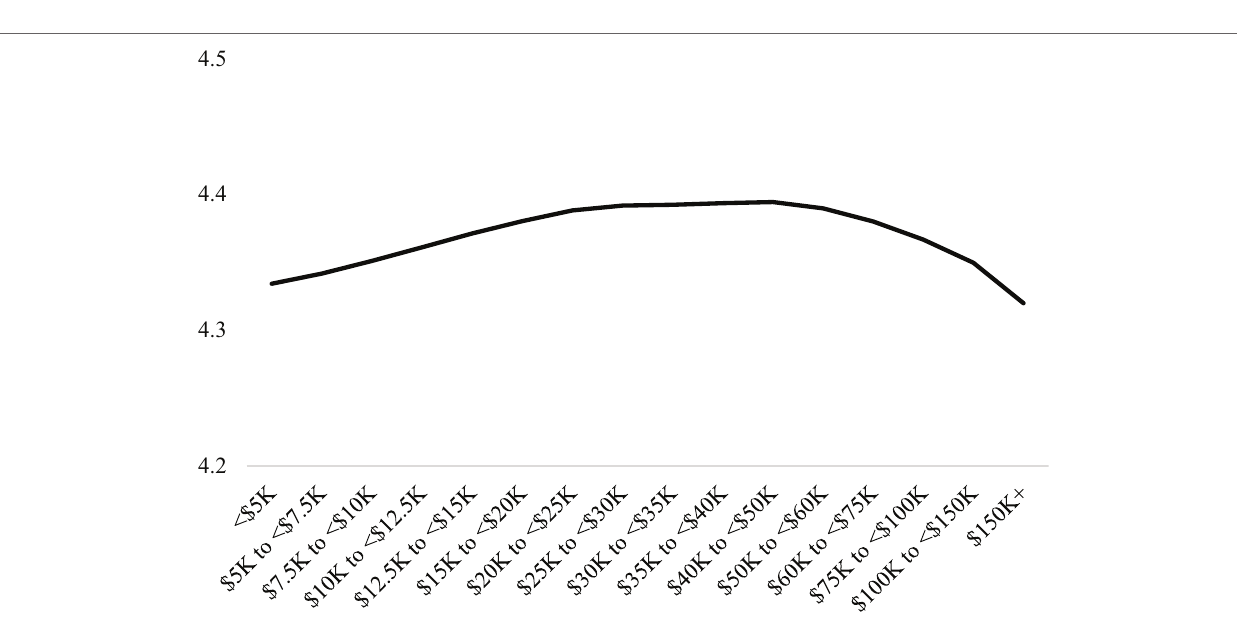
FIGURE 2 | Line graph of predicted values from lowess regressions explaining variance in happiness from income treated as a continuous variable in